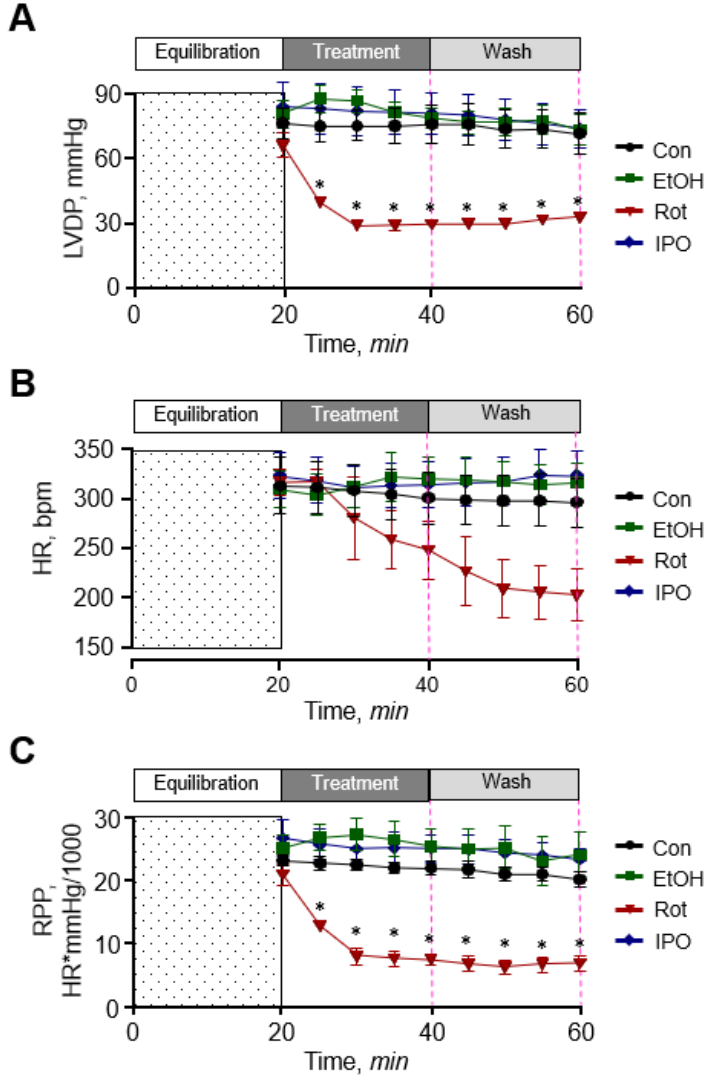
Figure 1. Cardiac function. ( A ) Left ventricular developed pressure (LVDP). ( B ) Heart rate (HR). ( C ) Rate pressure product (RPP). LVDP is the difference between left ventricular systolic pressure and left ventricular end-diastolic pressure. RPP was calculated as the product of LVDP and HR. Con, control; EtOH, ethanol; IPO, isopropanol; Rot, rotenone. * p < 0.05 vs. Con, n = 6–8.